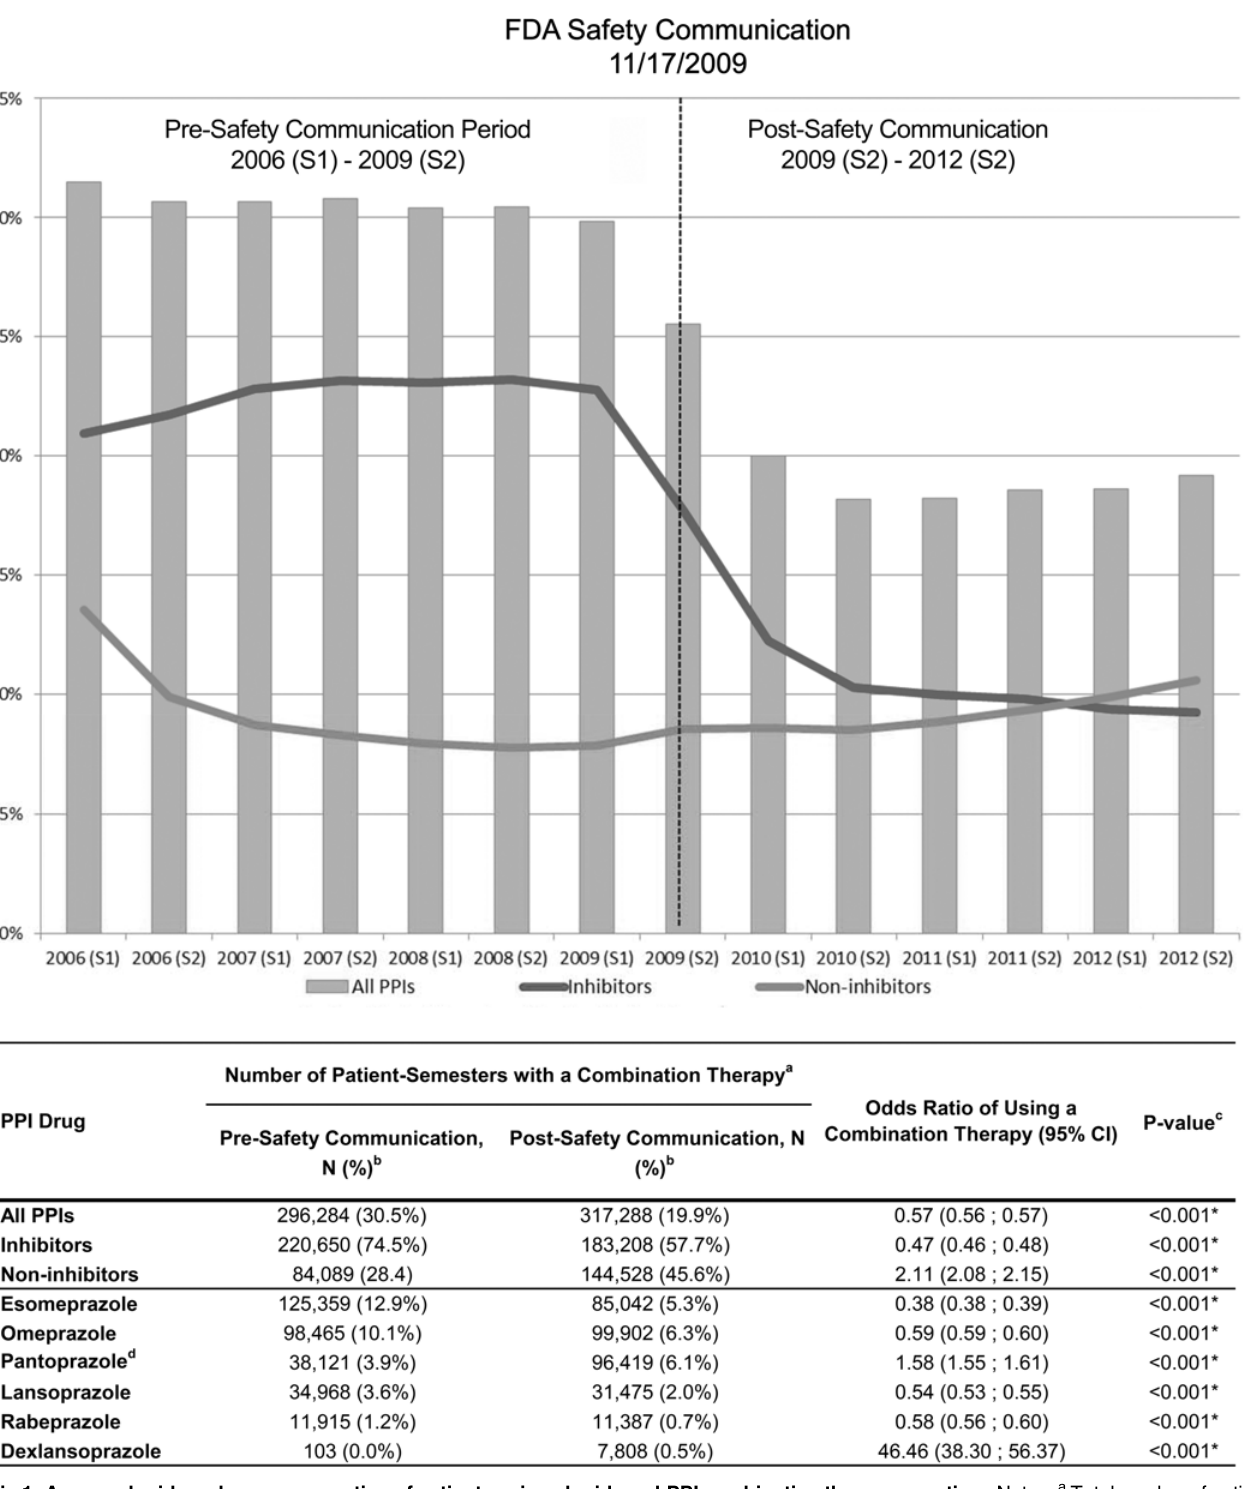
PLOS ONE | DOI:10.1371/journal.pone.0145504 January 4,